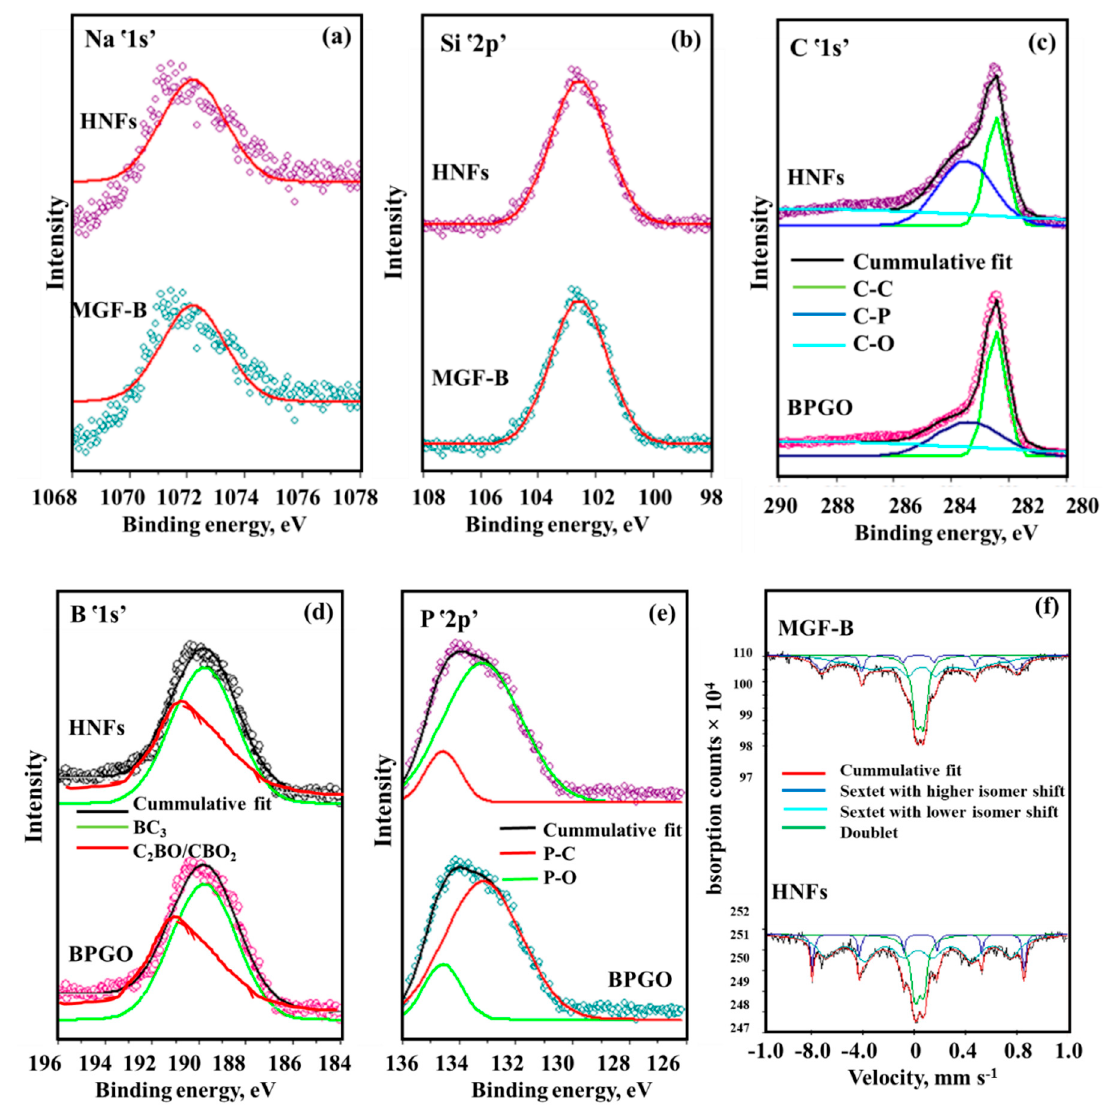
Figure 2. XPS high resolution spectra of ( a ) Na’1s’, ( b ) Si’2p’, ( c ) C’1s’, ( d ) B’1s’, ( e ) P’2p’ and ( f ) M ӧ ssbauer spectra of MGF − B and HNFs.